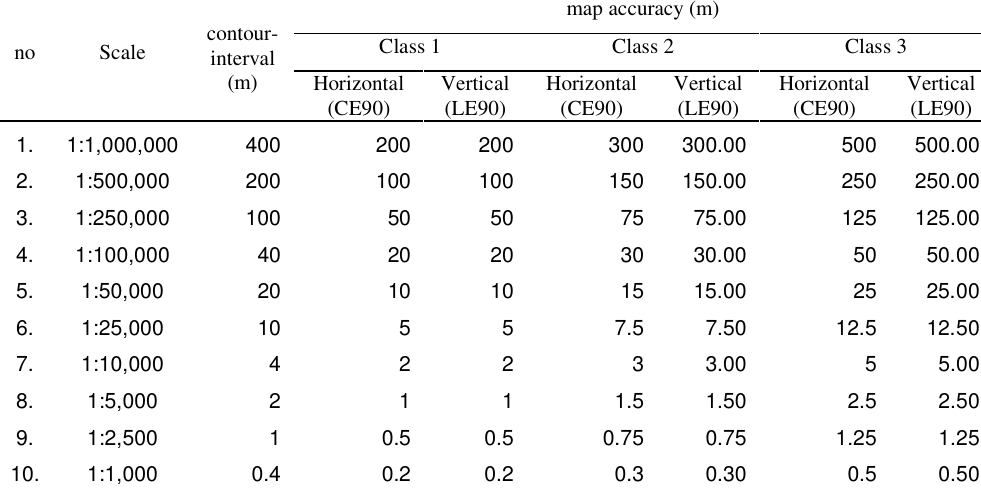
Table 1. Geometric Accuracy of RBI maps .